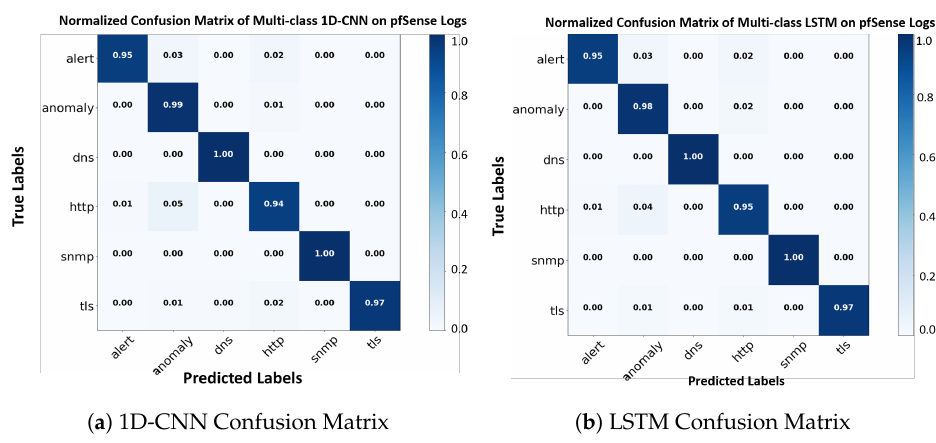
Figure 10. Confusion Matrices of the proposed 1D-CNN and LSTM Techniques: We observe that both techniques illustrate high detection rates of the correctly predicted classes, with the respect to their ground truth labels.